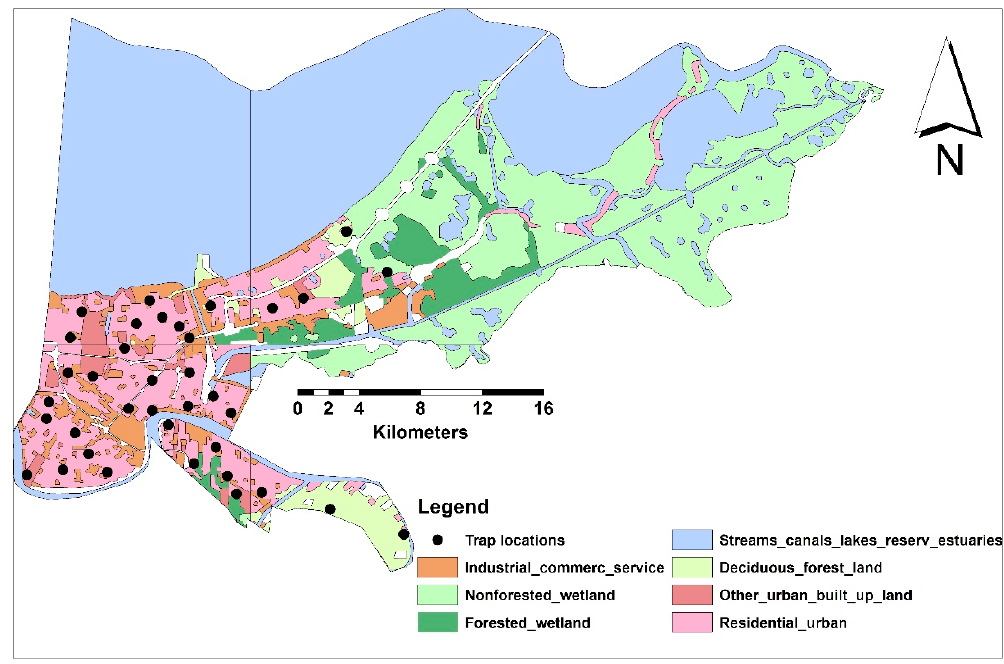
Figure 1. The seven LULC classes and sampling sites in NOLA.